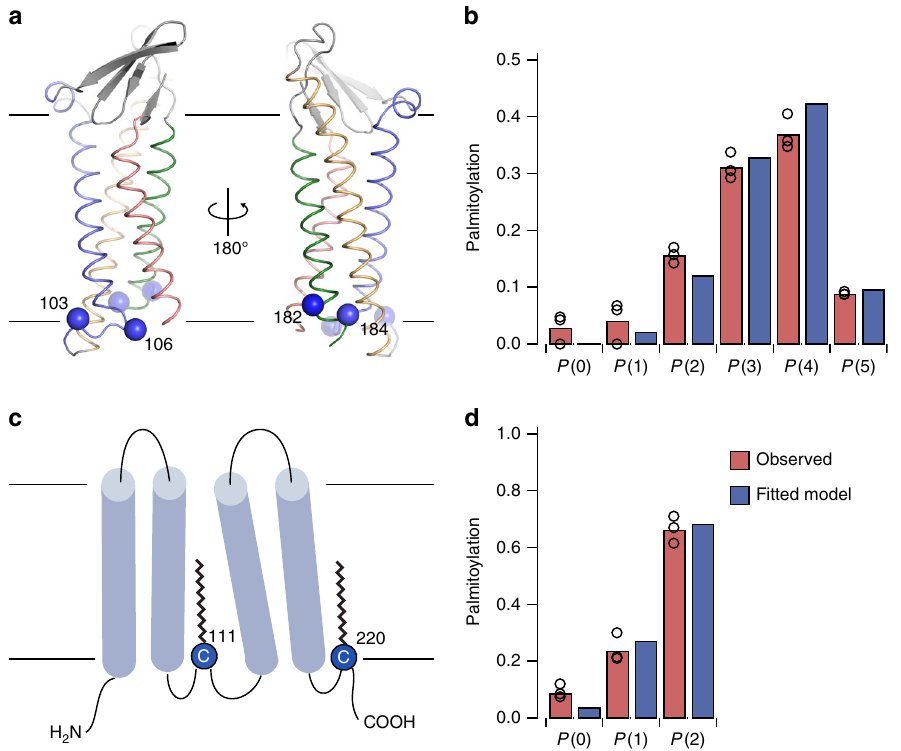
Fig. 3 Quantitative analysis of Cld3 and CD20 palmitoylation. Cartoon representation of the Cld3 model ( a ) and schematic representation of CD20 ( b ). Probability of cysteines to be palmitoylated in Cld3 is p 103 = 0.69, p 106 = 0.69, p 182 = 0.86, p 184 = 0.64 and in CD20 is p 111 = 0.74, p 220 = 0.82. C β atoms of palmitoylated cysteines shown as spheres and colored according to the probability to be palmitoylated in a white – blue gradient, in which full palmitoylation is shown as blue and no palmitoylation as white. b , d Comparison of the observed and calculated protein fractions for each palmitoylation state (P( n )) of wild-type Cld3 ( b ) and CD20 ( d ) after fi tting the cooperative stochastic model to palmitoyl distributions of all Cld3 or CD20 Fig. 8c). In the retinal-free state of bacteriorhodopsin, the state in